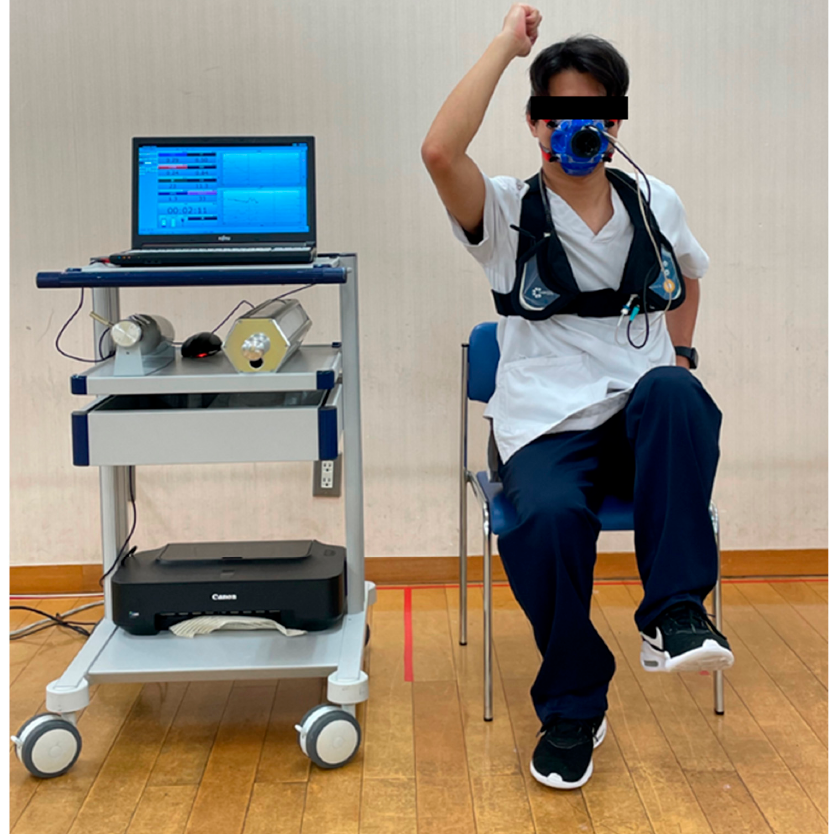
Figure 1. Photograph showing stepping and handshaking exercise in the sitting position (SHS) as a cardiopulmonary test.